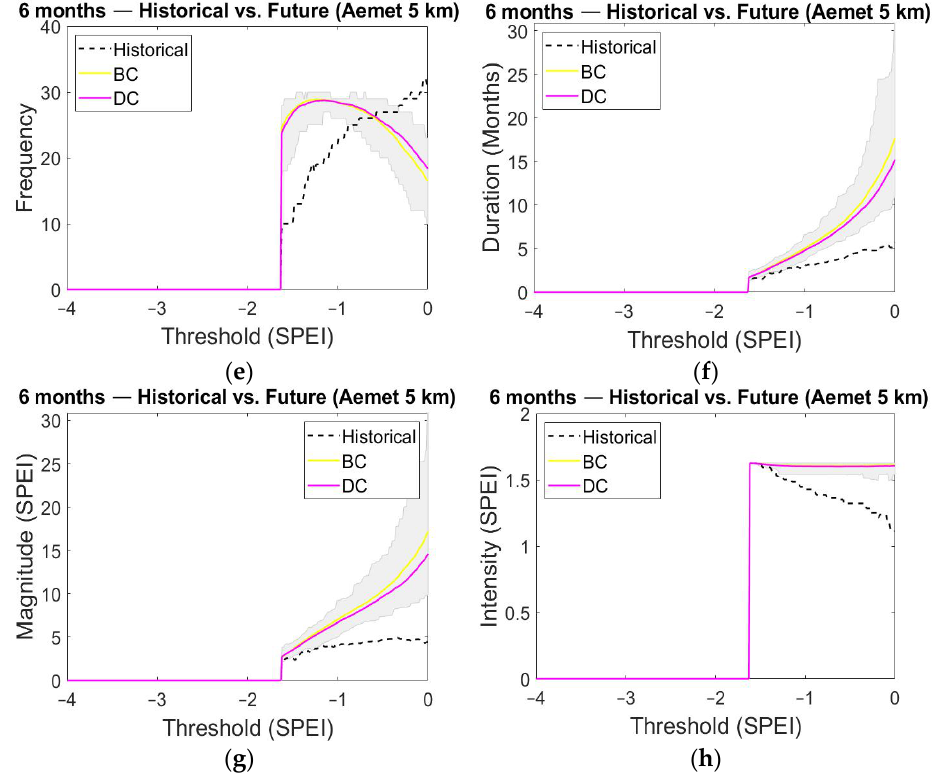
Figure A2. Historical and future meteorological drought ( a ) frequency; ( b ) mean duration; ( c ) mean magnitude; ( d ) mean intensity derived from SPI for the 6 months temporal-aggregation scale (Aemet 5 km database). Historical and future meteorological drought ( e ) frequency; ( f ) mean duration; ( g ) mean magnitude; ( h ) mean intensity derived from SPEI for the 6 months temporal-aggregation scale (Aemet 5 km database).